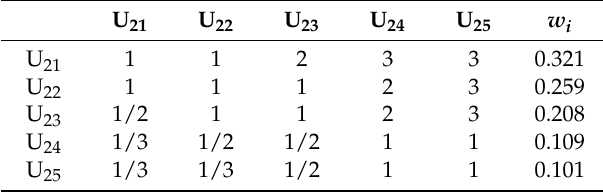
Table 5. Judgment matrix and validation of consistence for underground